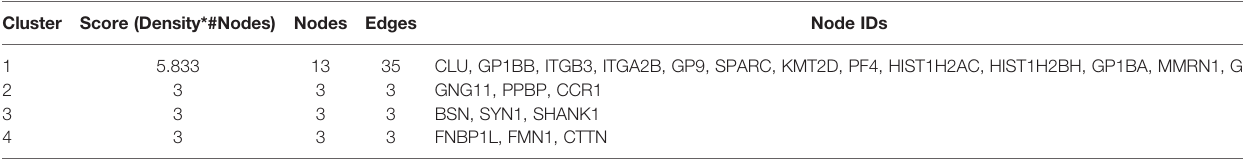
TABLE 2 | MCODE was used to process the data downloaded from the STRING to further mine gene clusters. Cluster Score (Density*#Nodes) Nodes Edges